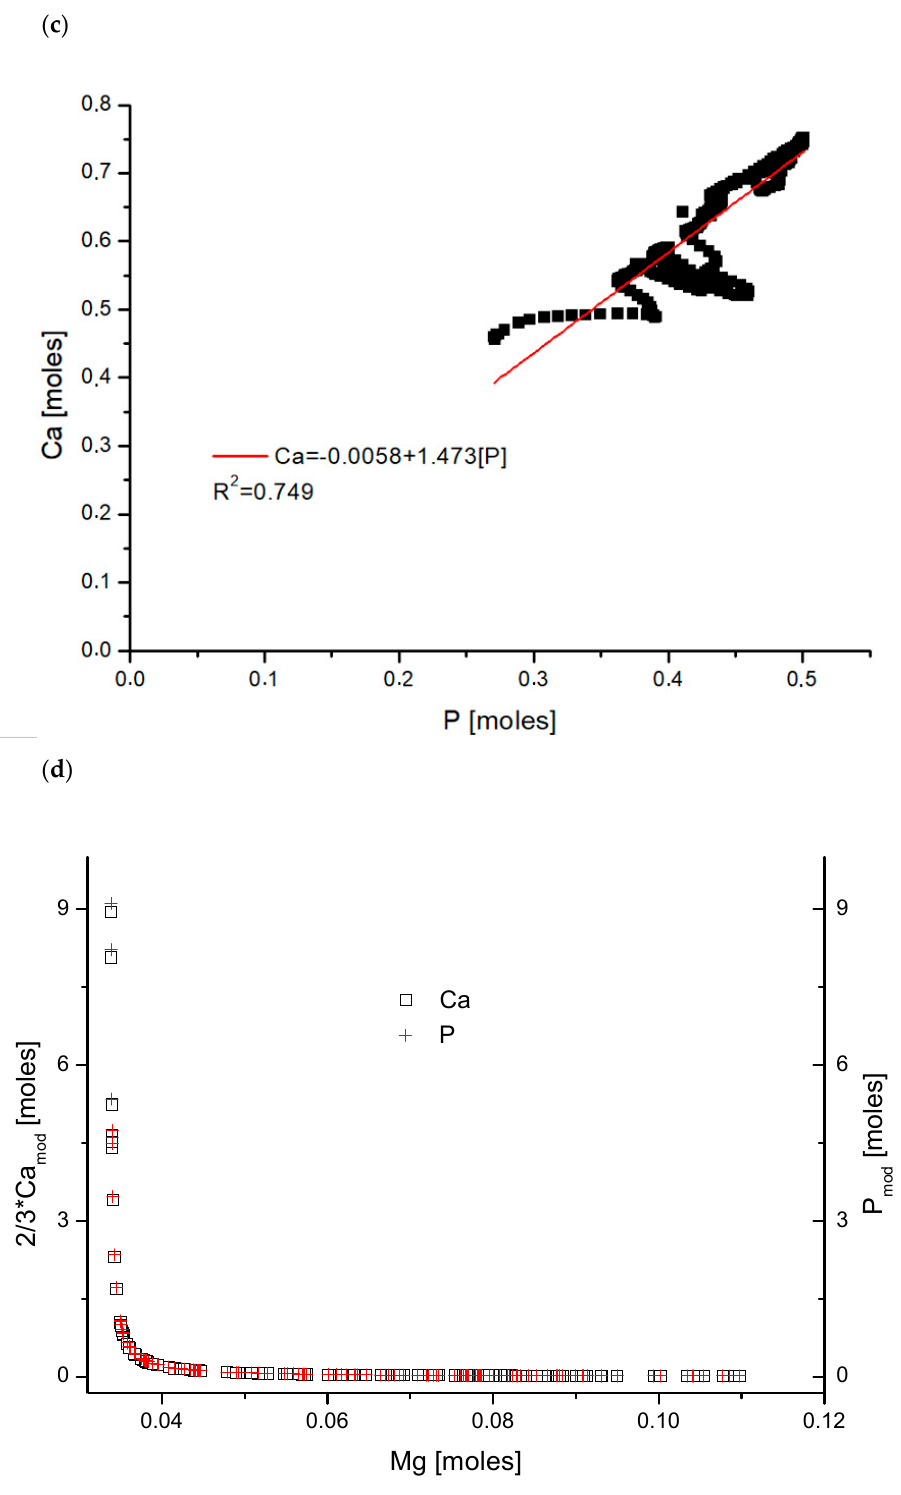
Figure 1. Sheep case: ( a ) strictly convergent spatial profiles of Ca/P and Mg–y axes are inversely oriented; the profile of Ca is added to show the enamel, dentin, and DEJ positions; ( b ) correlation between Ca/P and Mg with relevant equation; ( c ) correlation between Ca and P with equation; ( d ) distribution of Ca(*2/3) and P ions as fine hyperbolic functions of Mg concentration.